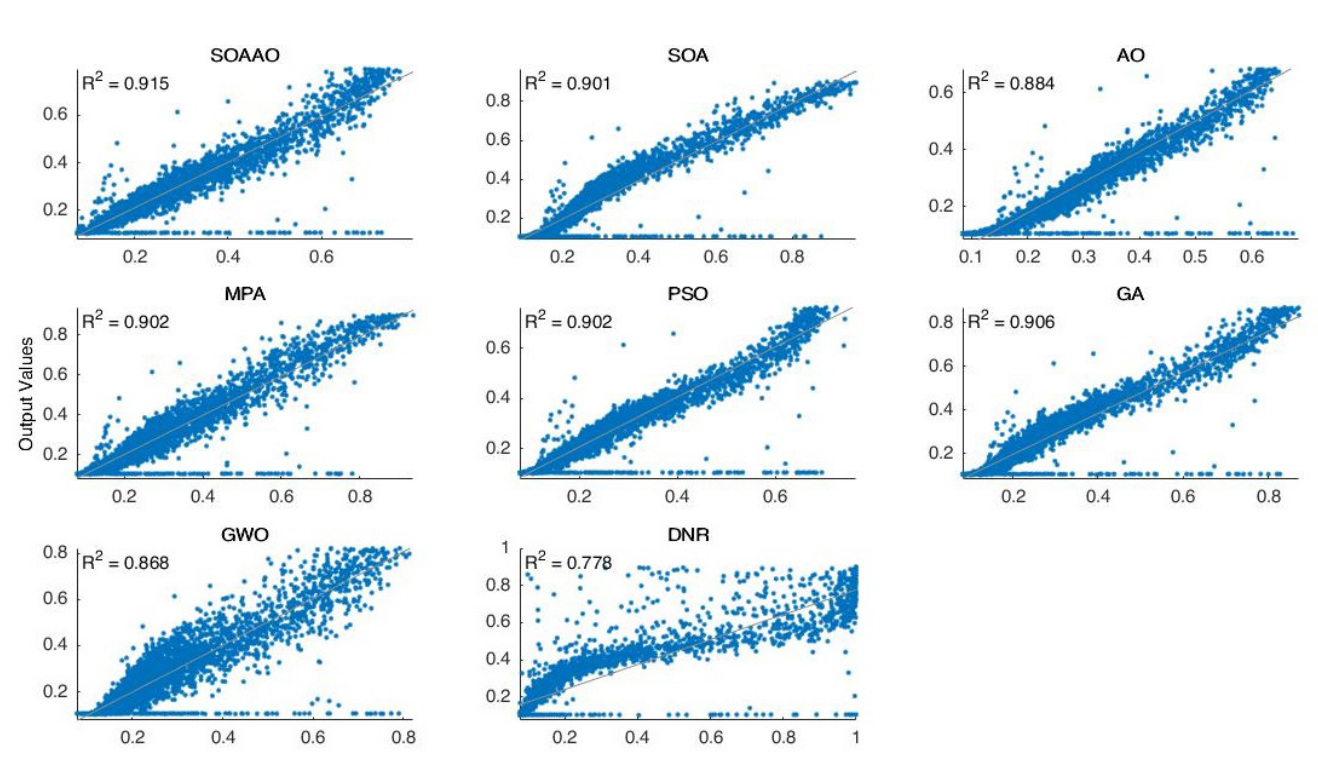
Figure 3. Results on DS4.